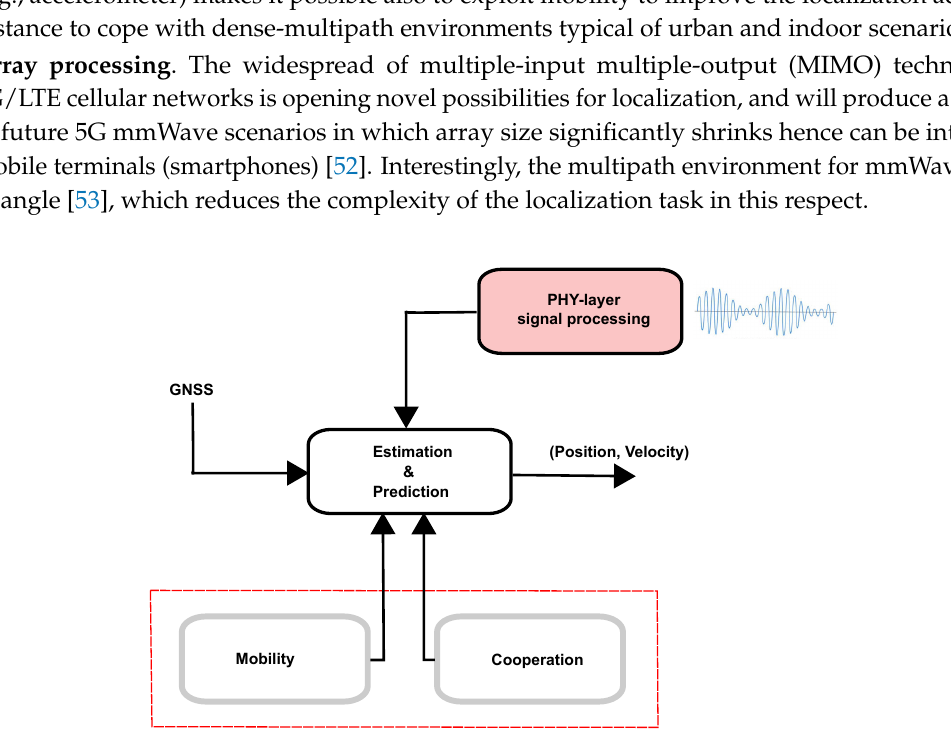
Figure 1. Three major ingredients for localization in emerging crowdsensing wireless sensor networks